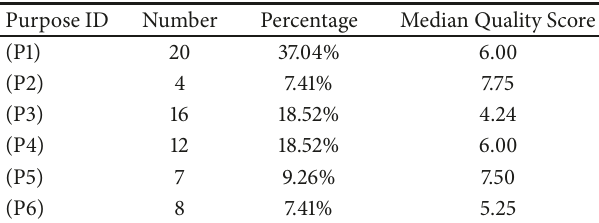
Table8:Summaryoftheidentifiedpurposesoftheselectedprimary studies and median quality scores.